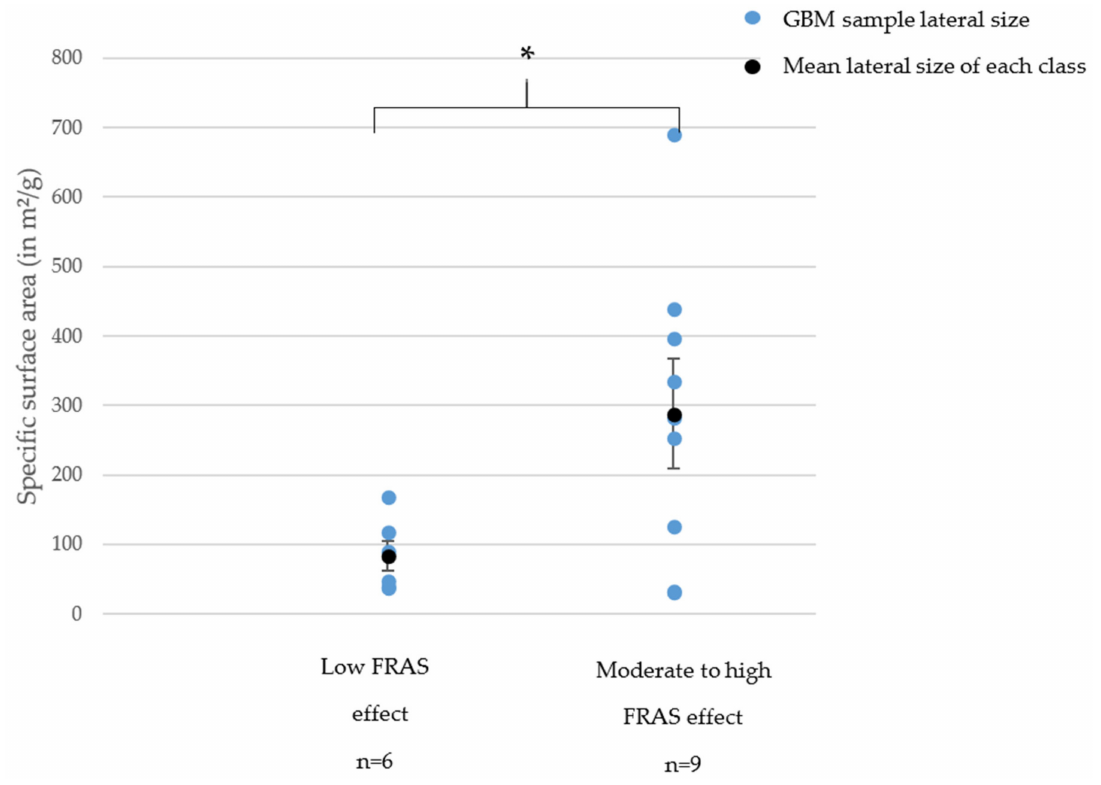
Figure 8. Structure–activity relationship between FRAS effect and specific surface area. * = p < 0.05 (Student